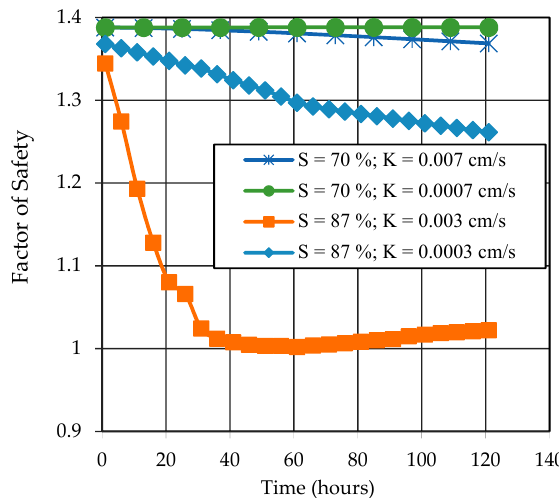
Figure 9. The factor of safety (FOS) results at an RI = 10 mm/h and with a different saturation degree and hydraulic conductivity.